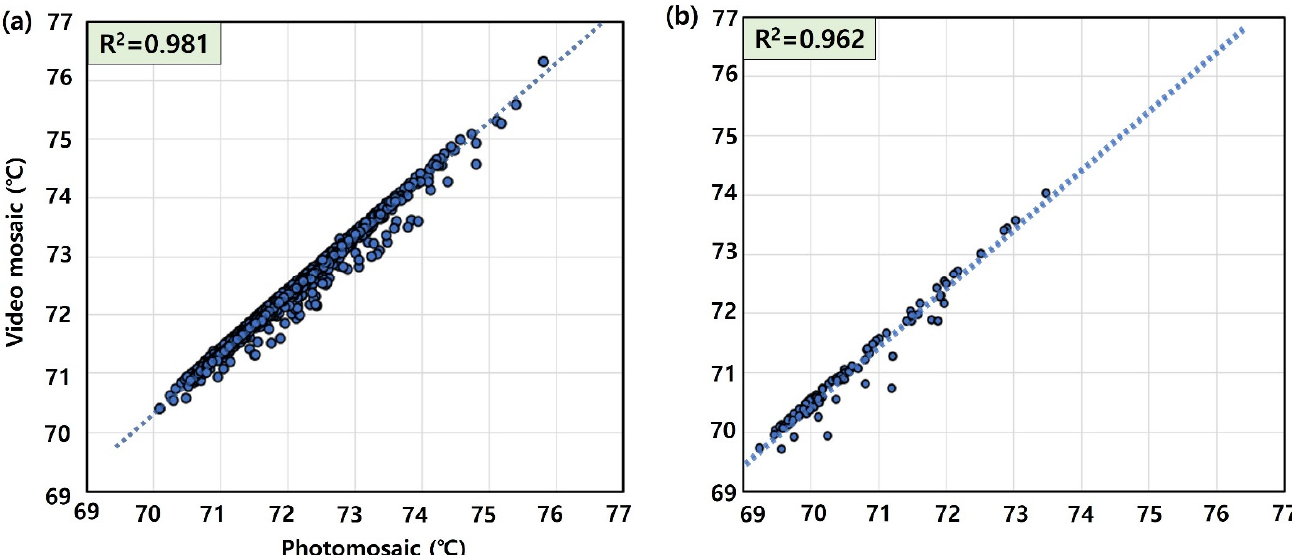
Figure 6. Scatter plots of SCSTs in matched hot spots between the photo-mosaic and video-mosaic. ( a ) Testbed 1; ( b ) Testbeds 2 and 3. ( a ) Testbed 1; ( b ) Testbeds 2 and